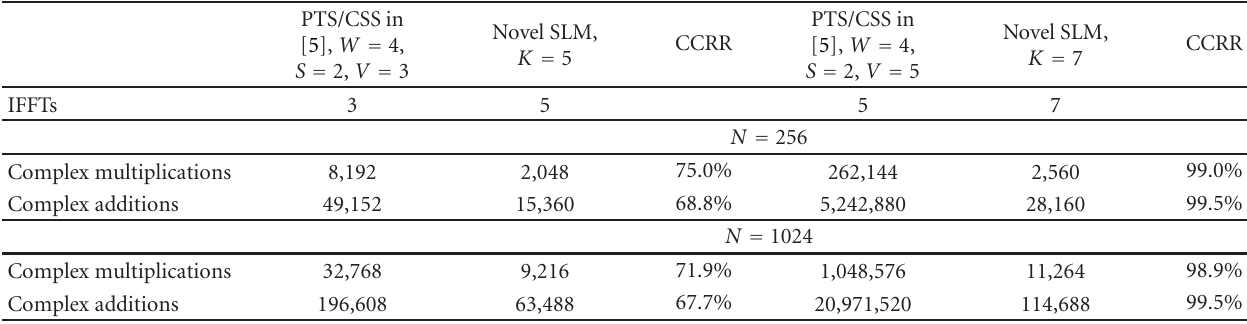
Table 6: Computational complexity of the SLM schemes in [5] and the novel SLM schemes when N = 256 and 1024. PTS/CSS in [5], W = 4,